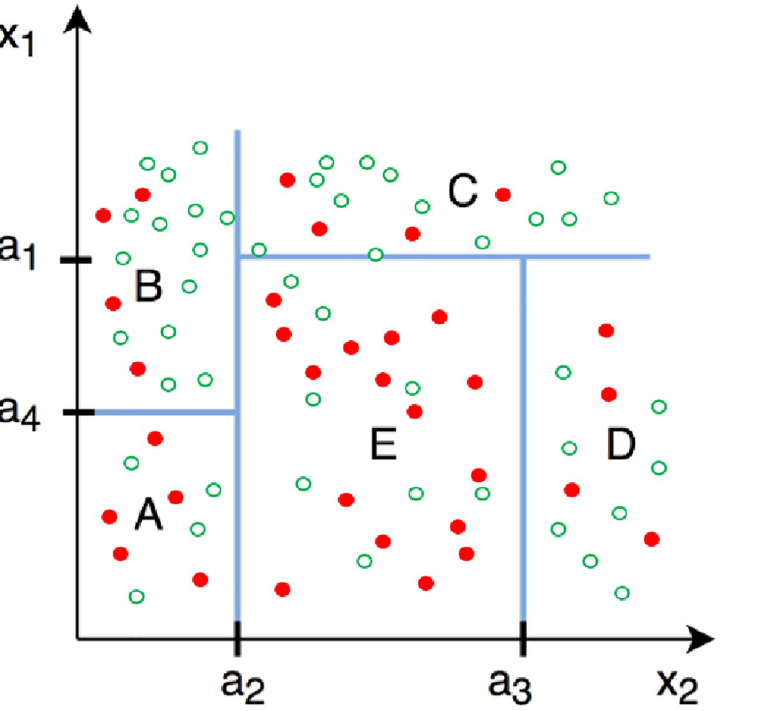
Fig 2. Decision tree data splitting. This is a revised figure, taken from Zou & Schonlau [17].